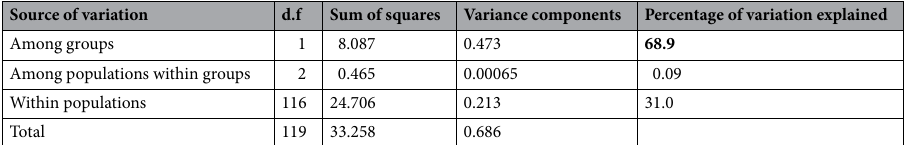
Table 4. Analysis of Molecular Variance (AMOVA) based on mtDNA comparing the Aphrastura population from Diego Ramírez to populations from other regions (see Table 1). Fixation Indices: FSC = 0.0030, FST = 0.69, FCT = 0.69. Statistically significant values are highlighted in bold.